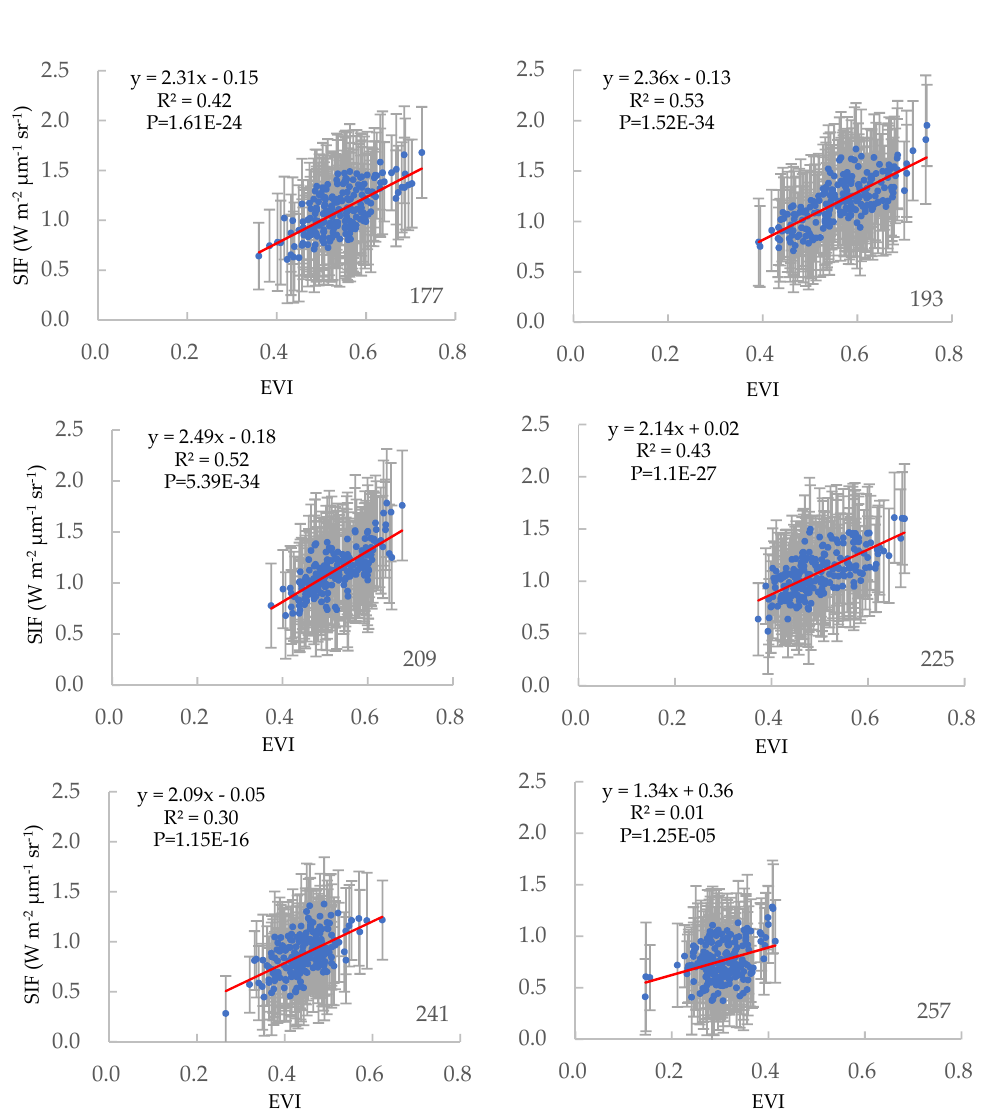
Figure 5. Scatter plots between SIF and EVI of each 16 ‐ day interval in 2015 and 2016.